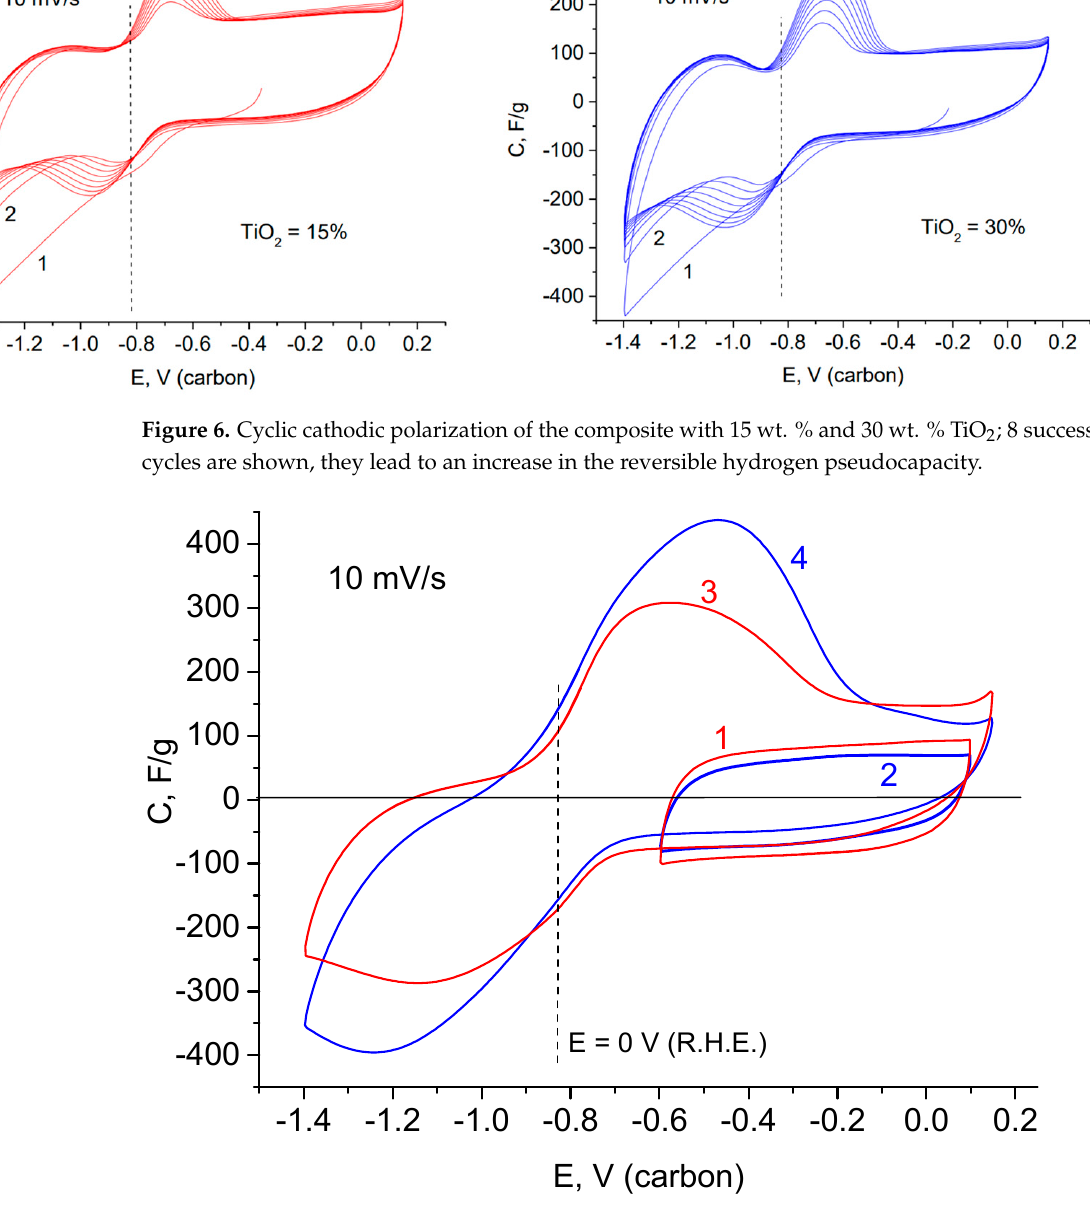
Figure 7. CVF curves: 1—rGO/TiO 2 15% (EDL region before cathodic polarization), 2—rGO/TiO 2 30% (EDL region before cathodic polarization), 3—rGO/TiO 2 15% (after deep cathodic polarization),